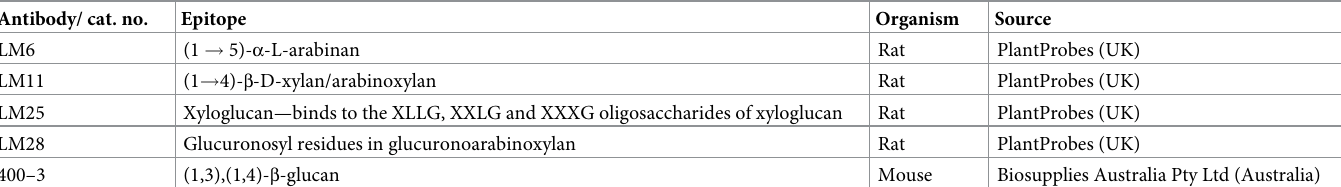
Table 1. Epitopes of commercial antibodies used in the study. Antibody/ cat.